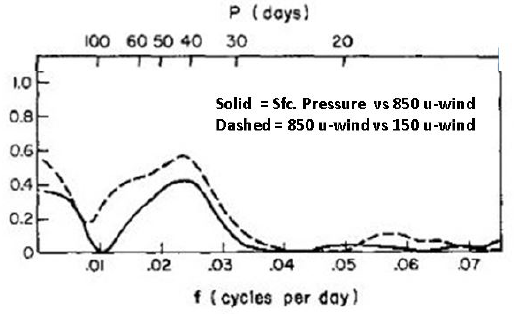
Figure 5. Coherence squared between 850 and 150hPa u winds (dashed) and between surface pressure and the 850hPa u winds (solid), based on Kanton Island pressure and upper-air data. The 0.1% prior confidence level, assuming a null of no coherence, is 0.25 (adapted from MJ71).